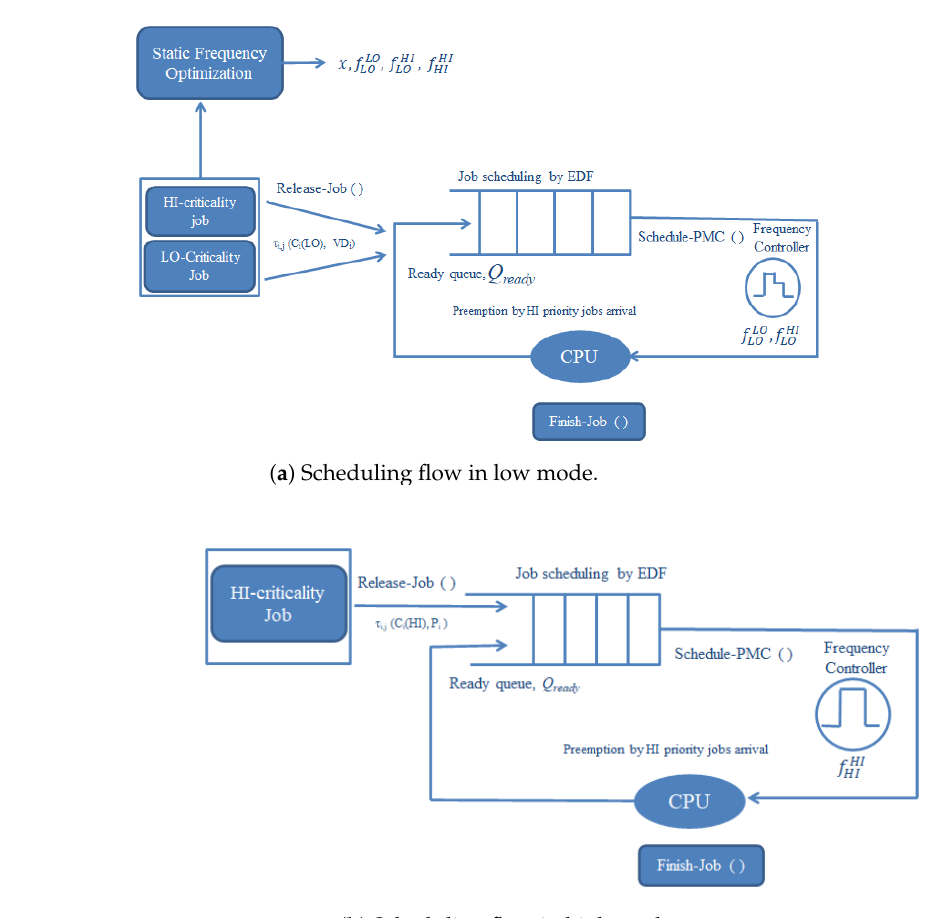
Figure 4. The proposed scheduling